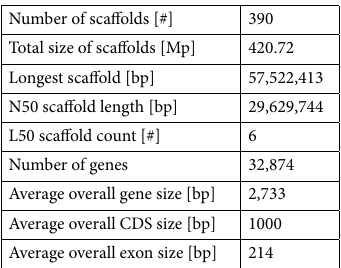
Table 1. Statistics for the C. humblotiana genome and gene